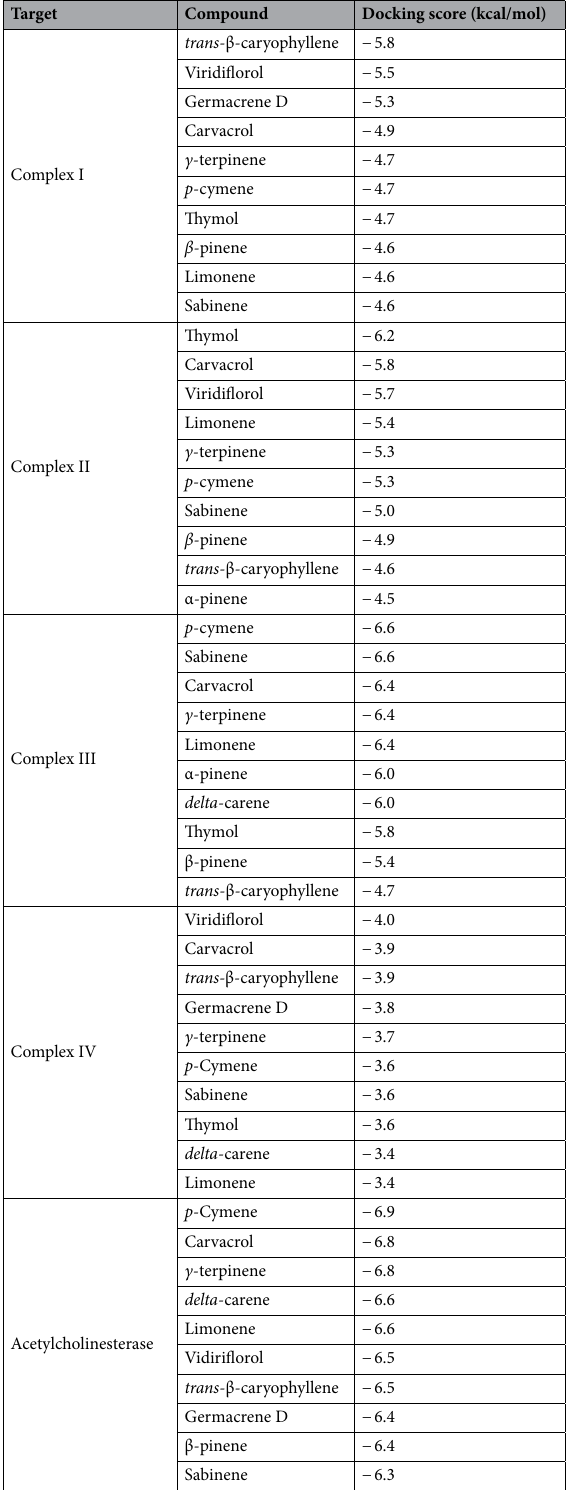
Table 2. Docking score and free binding energy calculation of best-ranked plant metabolites against selected molecular